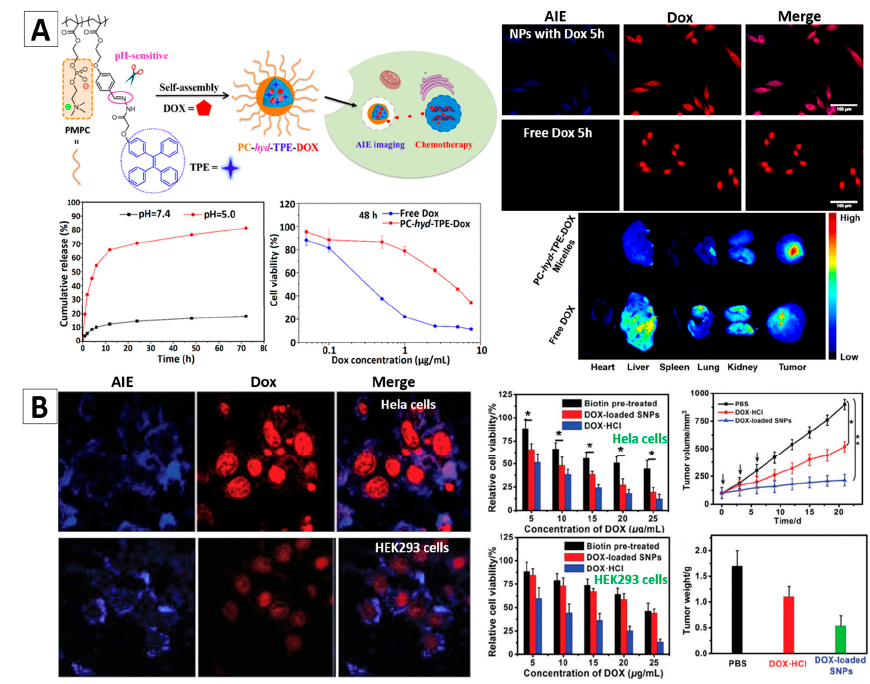
Figure 9. ( A ) PC-hyd-TPE micelles for combined AIE active imaging and pH-responsive drug delivery and release (in vitro and in vivo). Fluorescence images of HepG2 cells co-cultured with the DOX loaded micelles or free DOX for 5 h (top-right) and fluorescence images of excised tissues at 6 h post-injection of the DOX loaded micelles and free DOX (bottom-right) [95]; ( B ) HeLa and HEK293 cells incubated with DOX-loaded AIE-SNPs for 4 h; Cytotoxicity of HeLa and HEK293 cells with different treatments; Tumor growth inhibition curves on the HeLa tumor model after various formulations (* p < 0.05) and the average weight of the tumors of mice bearing HeLa tumors after different treatments [99]. Reprinted with permission from [95,99], respectively. Copyright 2016 American Chemical Society and Copyright 2016 The Royal Society Chemistry, respectively.